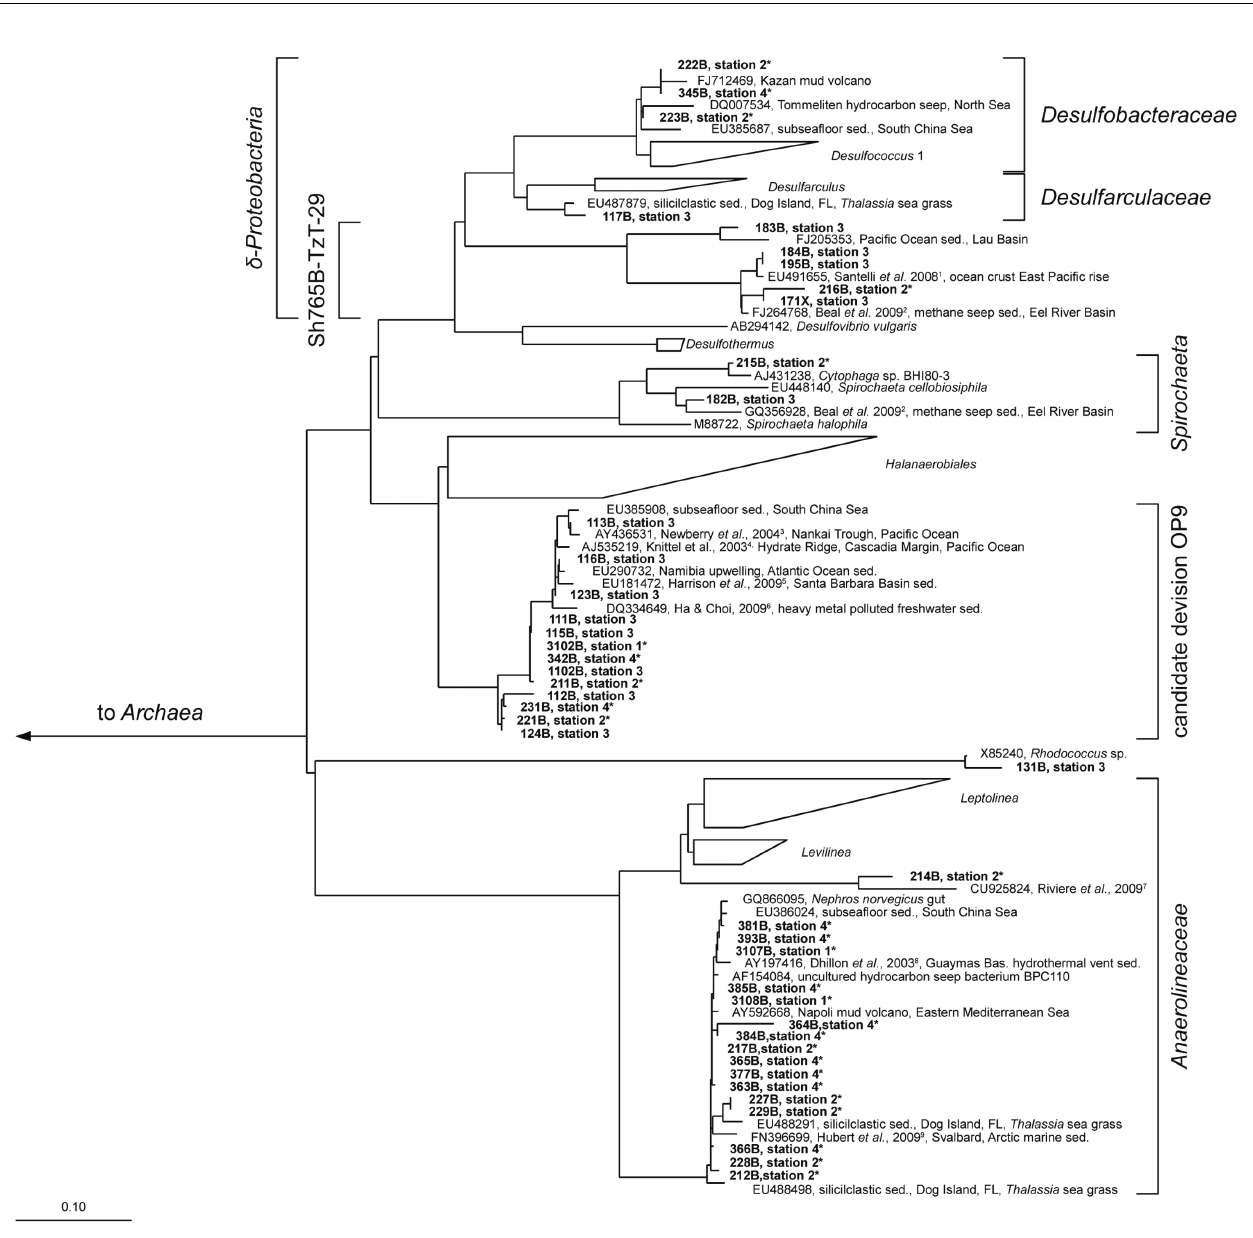
branching affiliations are shown. References are indicated in upper case: 1 Santelli et al. (2008), 2 Beal et al. (2009), 3 Newberry et al. (2004), 4 Knittel et al. (2003), 5 Harrison et al. (2009), 6 Ha and Choi (2009), 7 Rivière et al. (2009), 8 Dhillon et al. (2003), 9 Hubert et al. (2009). Asterisks ( ∗ ) indicate bands from DGGE gels in Figure 5 . sed.,